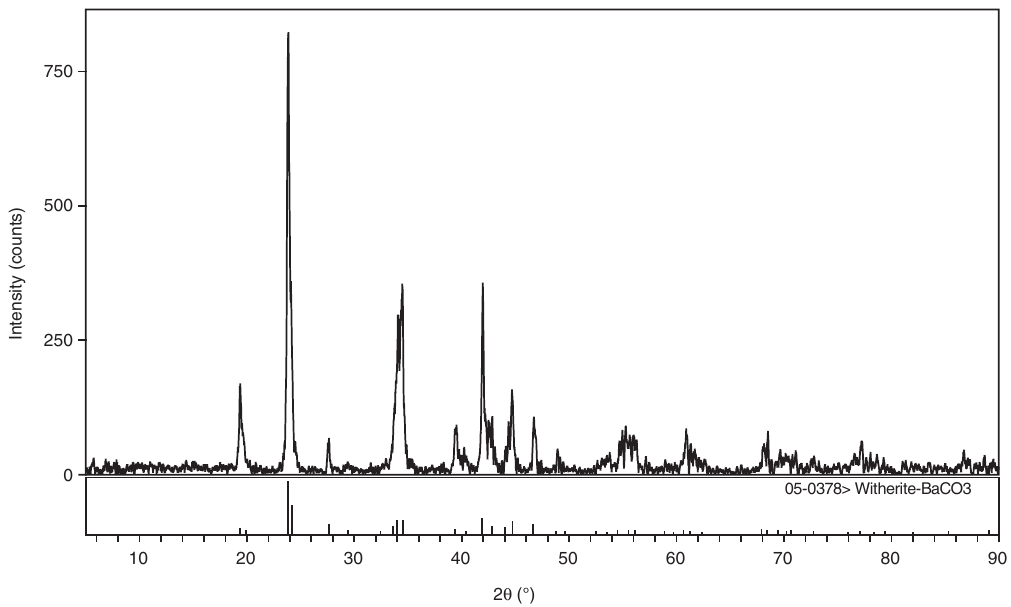
particles prepared by the homogeneous precipitation 3